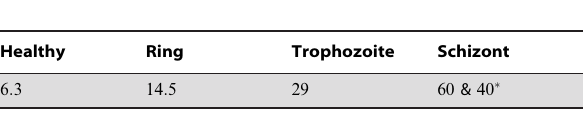
Table 1. Shear moduli of healthy RBCs and Pf-RBCs in m N = m at T ~ 23 o C .